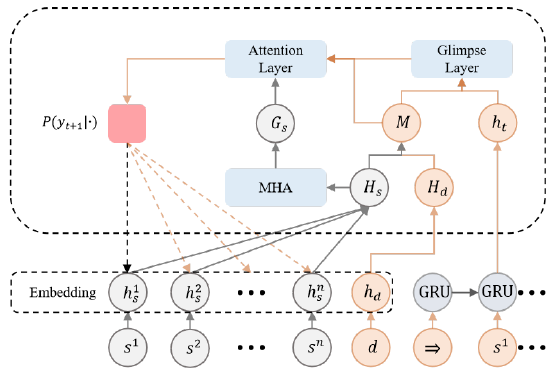
Figure 5. The overall structure of the HCNN